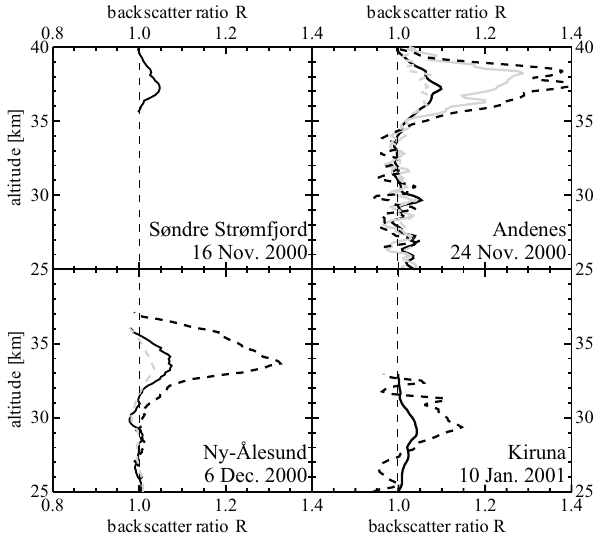
Fig. 2. Daily mean profiles of backscatter ratio for representative observations of the aerosol layer at each lidar station. Grey dashed: 355/353nm (Andenes/Ny- ˚Alesund); solid black: 532nm parallel polarised / non-polarised; black dashed: 532nm perpendicular po- larised; solid grey: